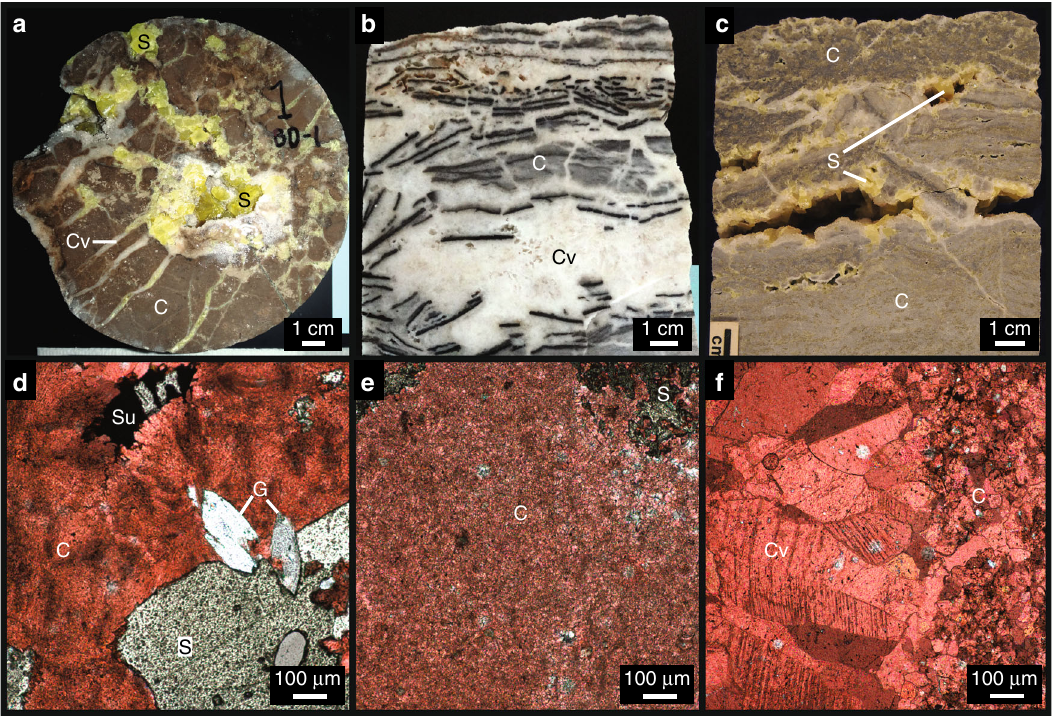
Fig. 2 Photographs and photomicrographs of Gulf of Mexico Basin cap rock. Samples from Boling Dome ( a , d ), Winn fi eld Dome ( b , e ), and Main Pass Dome ( c , f ) are pictured. Gypsum (G), host carbonate (C), vein carbonate (Cv), yellow elemental sulfur (S) and black metal sul fi de (Su) minerals are clearly visible in hand sample and thin section. Red stain in d – f indicates calcium